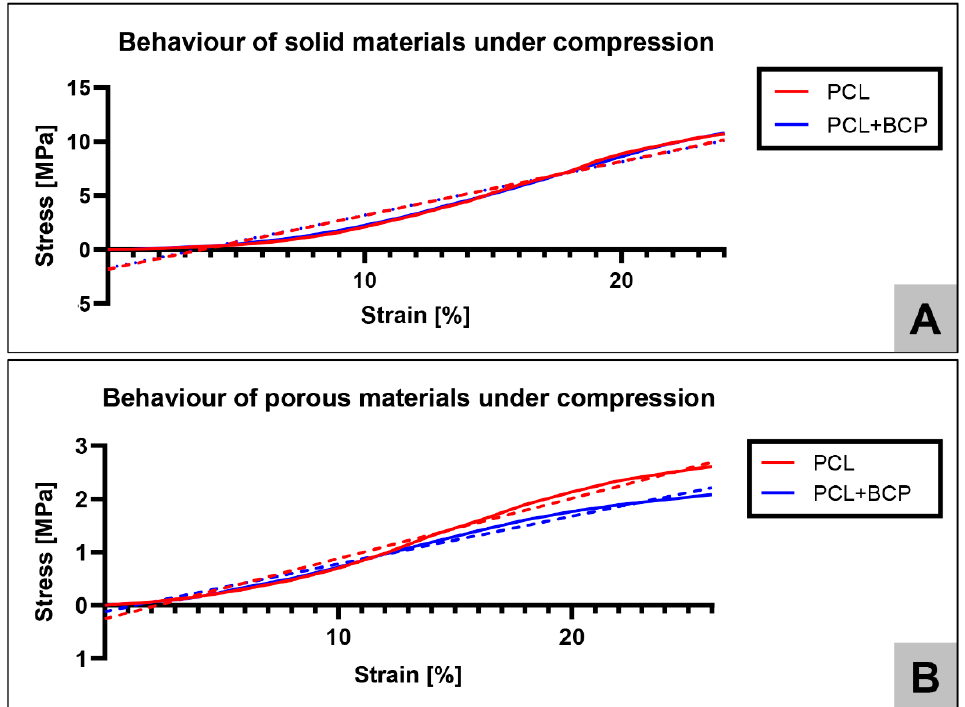
Figure 2. Stress-strain curves of ( A ) solid structures and ( B ) porous structures with dashed lines representing the linear regression curves. Table 2. Mechanical properties of PCL and PCL+BCP as solid and porous